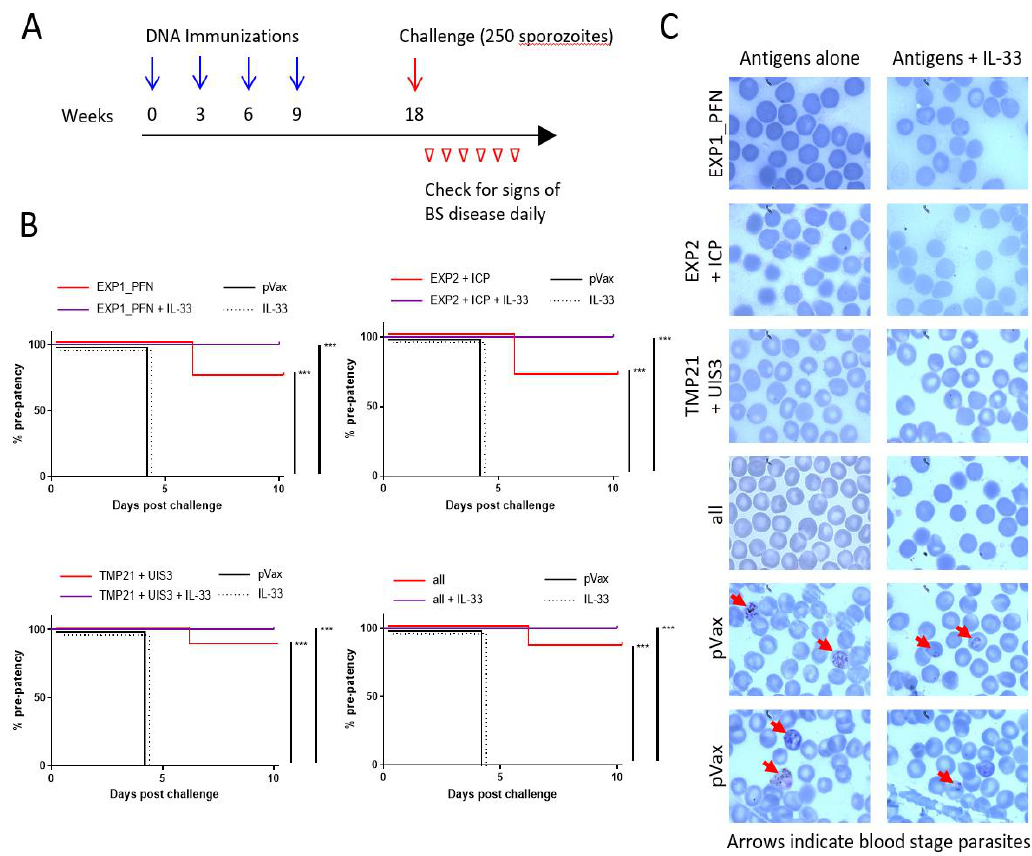
Figure 6. DNA vaccine expressing Py LS antigens provides protection from blood-stage disease after sporozoite challenge. ( A ) Vaccine and challenge timeline. BALB/cJ mice were immunized 4 times at 3-week intervals with the indicated vaccine co-formulations. Immunization groups were: EXP1_PFN with or without IL-33, EXP2 and ICP with or without IL-33, TMP21 and UIS3 with or without IL-33, and all vaccine constructs together with or without IL-33. Mice were then challenged by injection of 250 P. yoelii sporozoites. Blood smears were examined daily for signs of blood-stage disease. ( B ) Survival curves showing protection from evidence of blood stage parasites. Log-rank tests were used to compare groups and p -values less than the Bonferroni-corrected threshold are indicated. *** = p < 0.001. ( C ) Example blood smears from each group. Red arrows indicate blood stage parasites. All antigen immunized groups with and without IL-33 were n = 7 or 8. pVax and IL-33 groups were n = 5. See Supplementary Table S1 for more details.